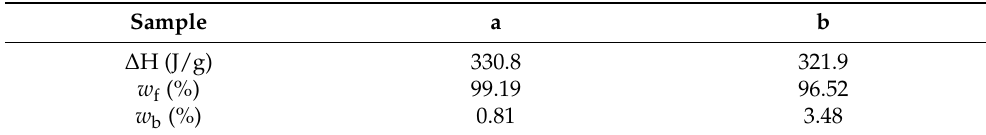
Table 1. Mass fractions of bound water and free water in gel samples.